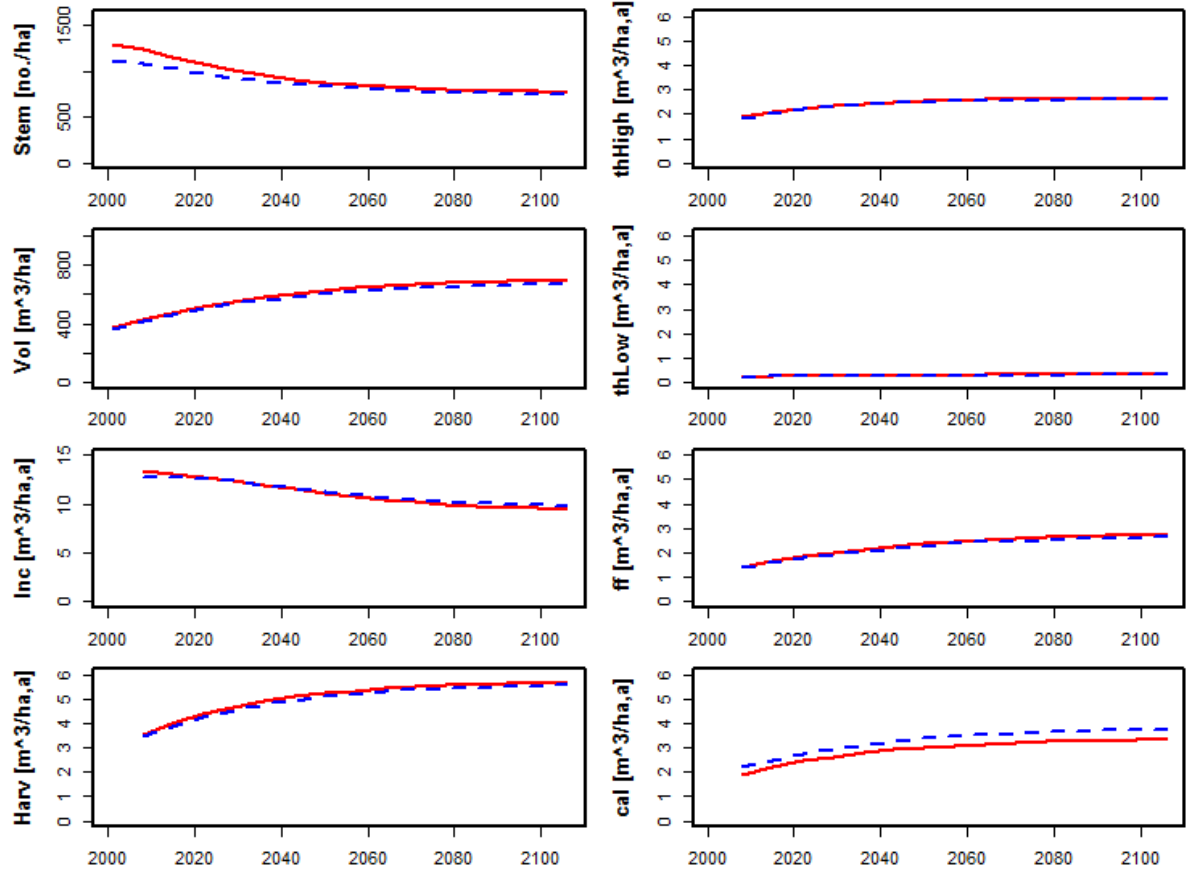
Figure 2. Development of the Norway spruce forest on elevation class 1 (red line) and 2 (blue dash line) when harvests are simulated. The calamity coefficients are 0.42 (elevation 1) and 0.5 (elevation 2). Probabilities for activities are: 9% (high thinning), 2% (low thinning), and 9% (final